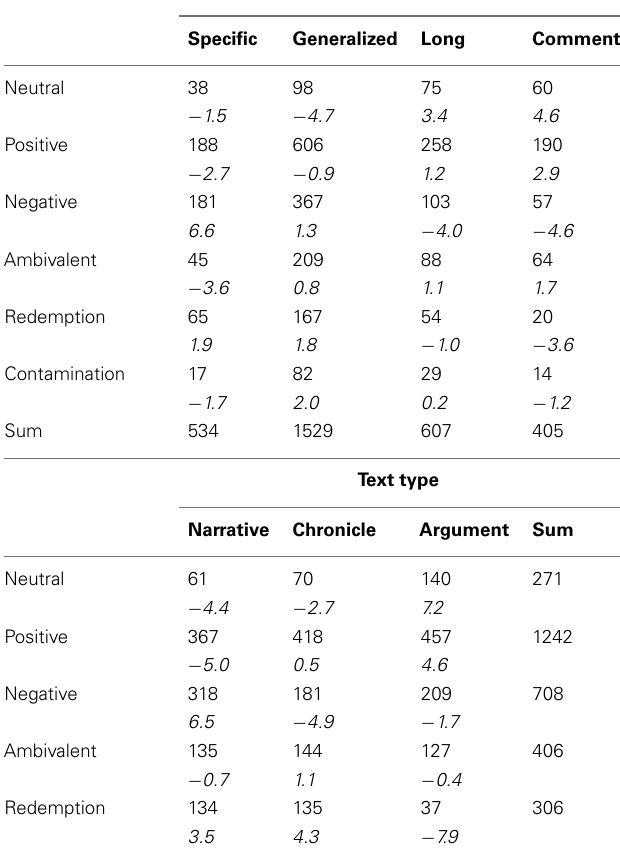
Table 4 | Crosstabulation of evaluative patterns with text and memory